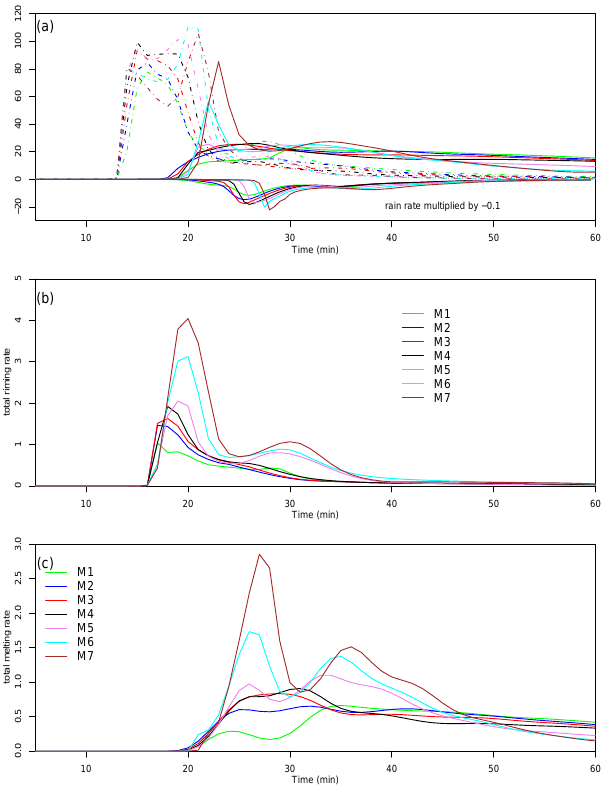
Fig. 12. Tropical Pacific clouds: (a) The sum of drop mass (g kg − 1 in dash-dotted lines), graupel mass (g kg − 1 in solid lines) at the level just above 0 ◦ C. The precipitation rate in Fig. 4 is also added in the figure for reference. Note that the precipitation rate is multiplied by − 0.1 to avoid congestion in the figure. Temporal variation of total riming rate (b) and total melting rate (c) from TP-v2 cases. The units are g kg − 1 s − 1 .